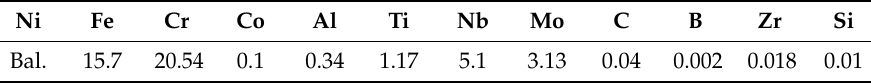
Table 2. The average chemical composition of SLM IN718